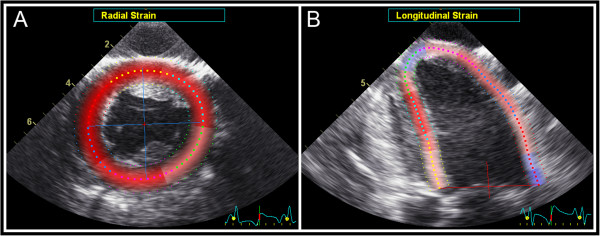
Speckle Tracking Echocardiography (STE). (A) Epicardial left ventricular short-axis view used for STE. During analysis, knots (square-like points) are evenly distributed along the middle of the region of interest and the region of interest is itself divided into six standardized segments. Tracking of these knots from frame to frame is used for estimation of radial and circumferential strain in each segment. The anterior and posterior wall was defined as the yellow and pink segment, respectively. (B) Epicardial left ventricular long-axis view used for STE. The same principle is used for estimation of longitudinal strain in each segment. The anterior and posterior wall was defined as the dark blue and cyan segment, respectively.